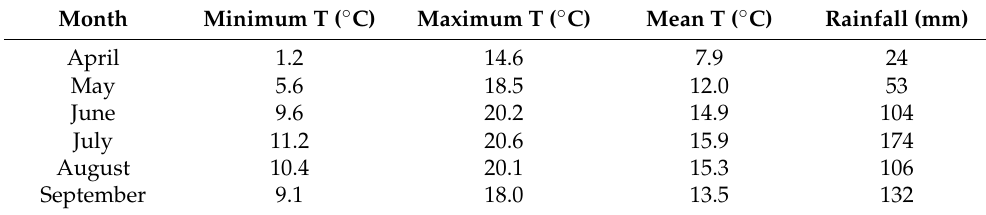
Table 1. Monthly minimum temperature, maximum temperature, mean temperature, and rainfall from April to September during the cropping period in